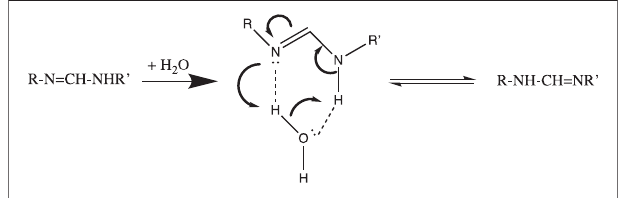
FIGURE 2 | Water-catalyzed 1,3-tautomerization.